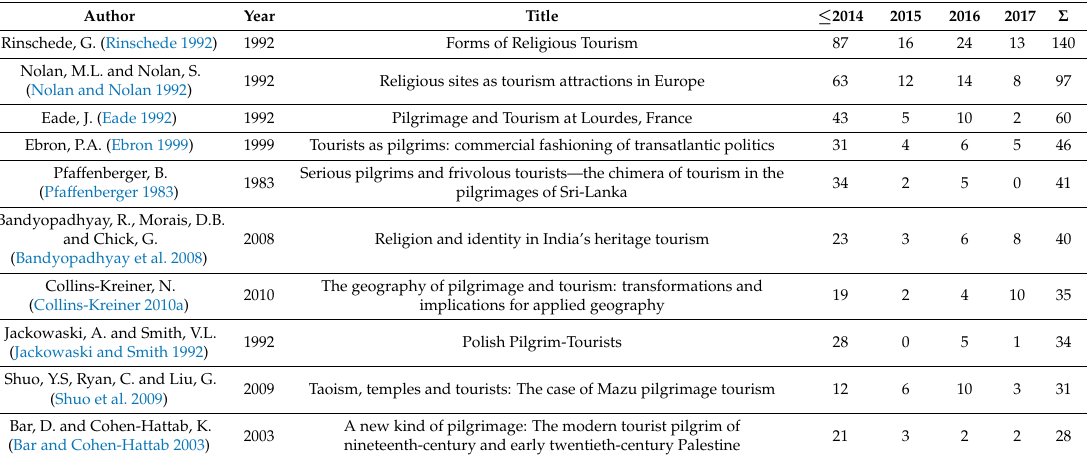
Table 3. Most cited articles in WoS about Religious Tourism.